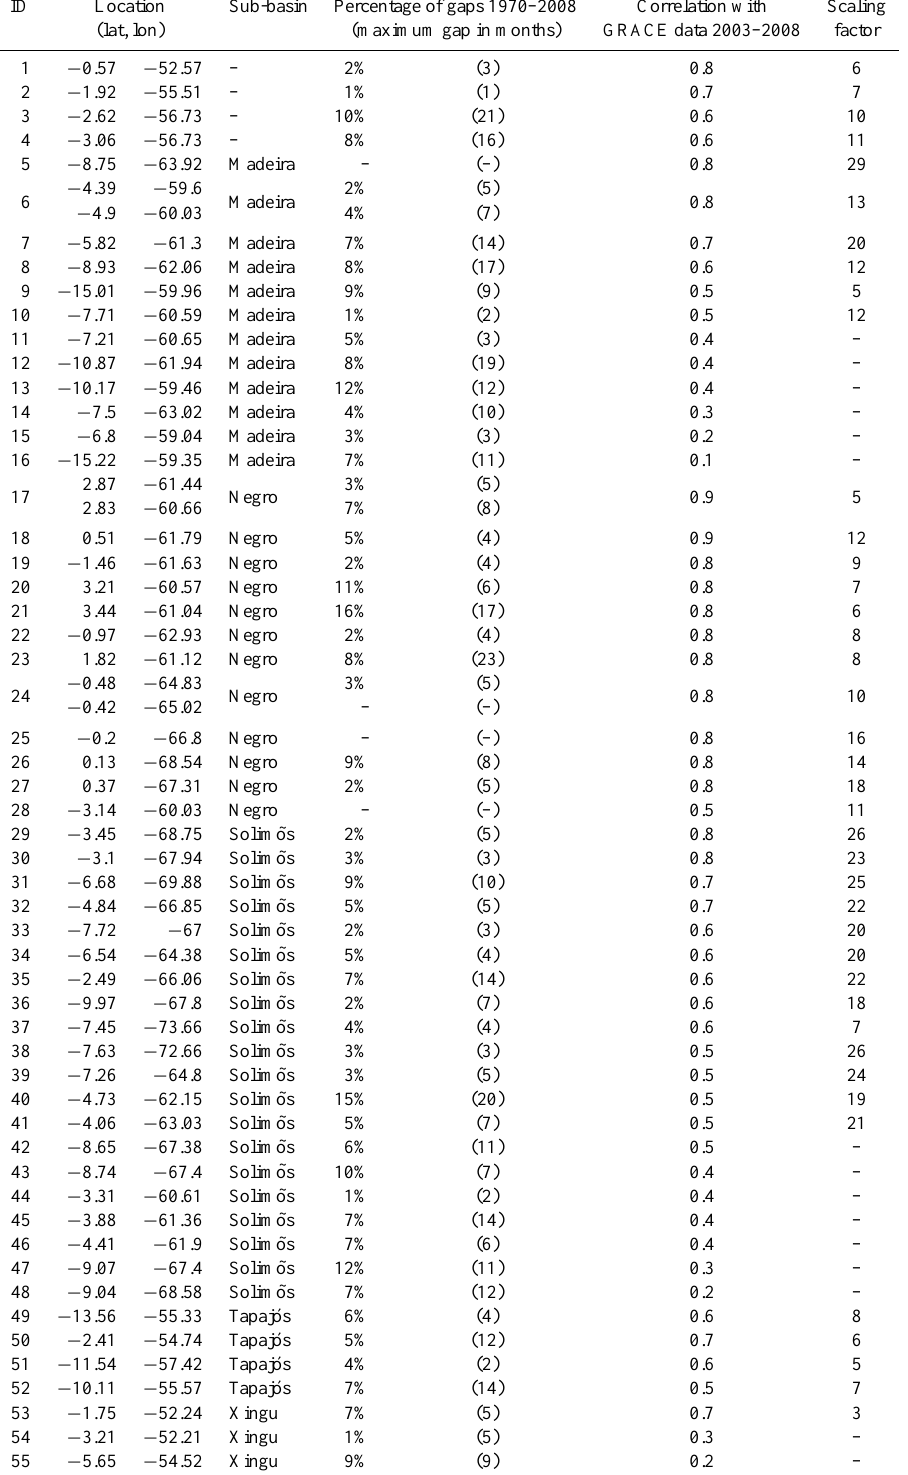
Table 1. Characteristics of the in-situ river level stations: location (latitude, longitude), name of the sub-basin, percentage of gaps in the record over 1980–2008 and maximum of consecutive months missing in the record (in the brackets, “–” means that no month is missing). Correlation GRACE-based TWS data over 2003-2008 (SL > 99%) and corresponding scaling factor. We average three pairs of in situ stations (ID: 6, 17 and 24) because these stations are in the same 1 ◦ × 1 ◦ GRACE